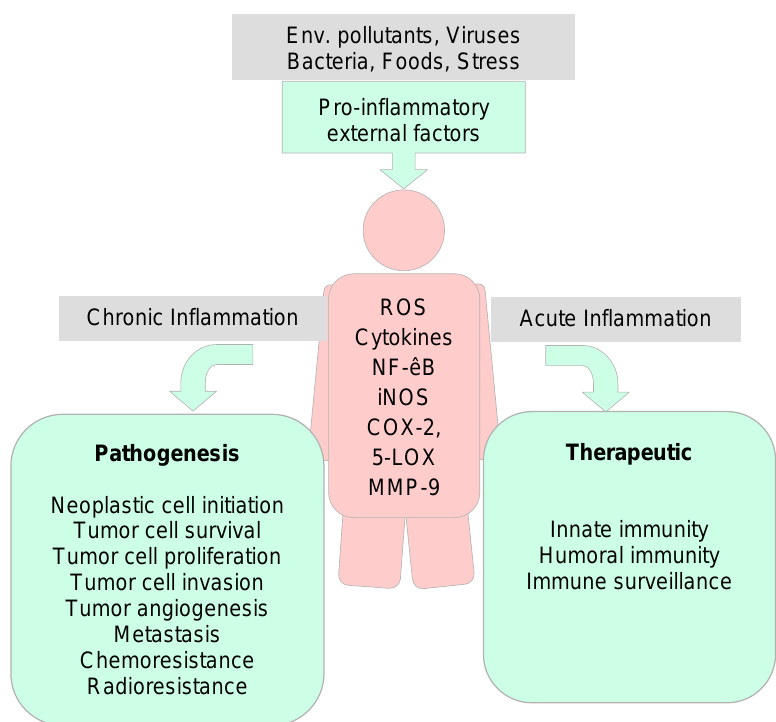
Figure 4. Chart showing external and internal pro-inflammatory factors and some of their biological